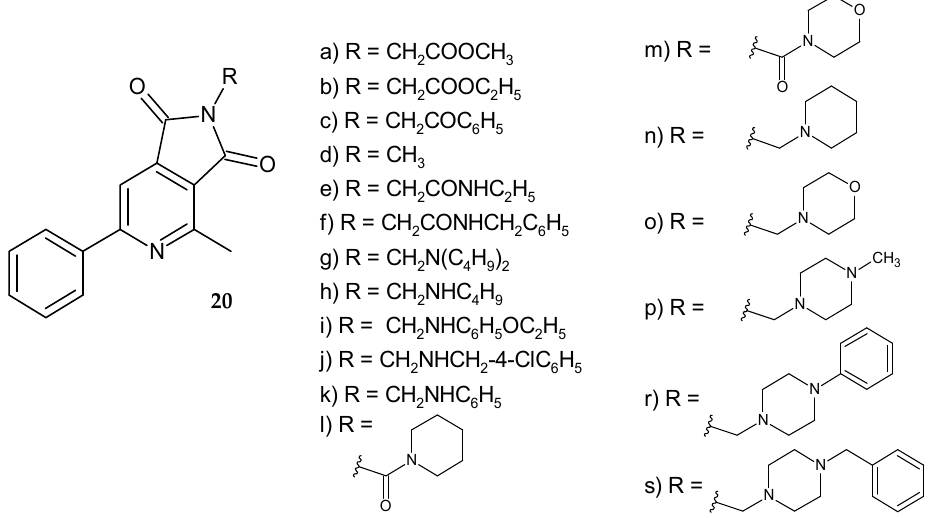
Figure 15. N ‐ alkil ‐ 4 ‐ methyl ‐ 6 ‐ phenyl ‐ 1 H ‐ pyrrolo[3,4 ‐ c ]pyridine ‐ 1,3 ‐ dione derivatives 20a ‐ s . Phosphoinositide 3 ‐ kinases (PI3Ks) are a family of intracellular lipid signaling enzymes that catalyze the phosphorylation of the hydroxyl group in the 3 ‐ position of the phosphatidylinositol ring. PI3Ks can control many vital cellular processes such as growth, proliferation, and survival. Therefore, the inhibition of PI3Ks can be used in anticancer therapy.